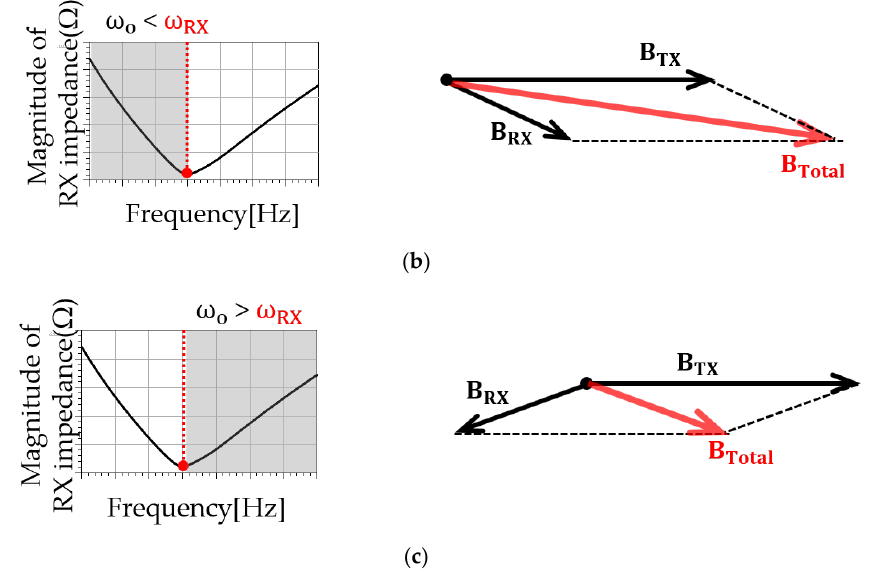
Figure 5. Various cases for the magnitude of RX part impedance and vector diagram of 𝐈 𝐓𝐗 ( 𝐁 𝐓𝐗 ) and 𝐈 𝐑𝐗 ( 𝐁 𝐑𝐗 ) depending on 𝜔 𝑅𝑋 and 𝜔 𝑜 : ( a ) 𝜔 𝑅𝑋 = 𝜔 𝑜 ; ( b ) 𝜔 𝑅𝑋 > 𝜔 𝑜 ; ( c ) 𝜔 𝑅𝑋 < 𝜔 𝑜 .